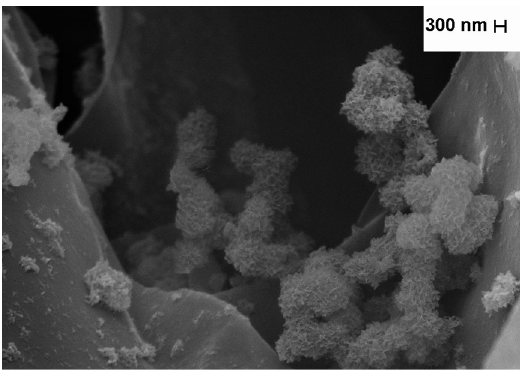
Figure 3. SEM images of QNM. Magnification of 20.000 x. EDS analysis (Figure 4) indicated that HA deposits consist of calcium, phosphorous, and oxygen and no other elements were observed, confirming the high purity of the calcium phosphate. The Ca/P molar ratio for QNM was 1.44 ± 0.03 that indicates a calcium deficient